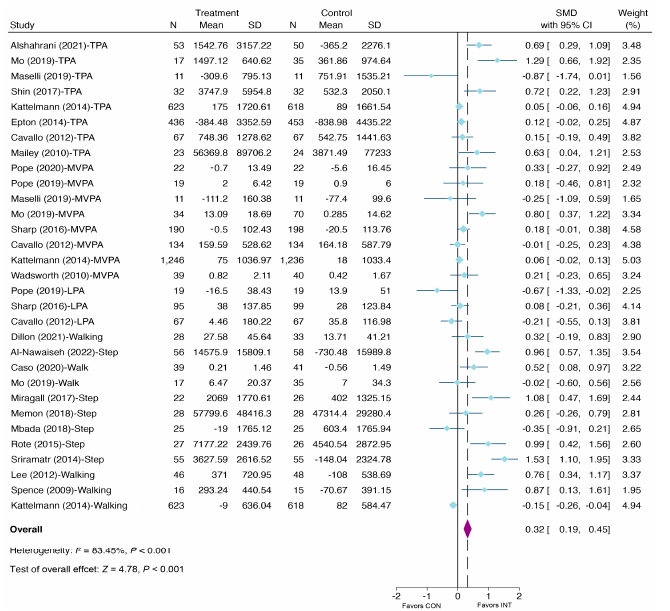
Figure 4. Meta-analysis of effects of e-health interventions on PA at post-intervention versus control [36,37,44–63]. A meta-analysis of the random effect model for five effect sizes reporting SB-related outcomes found that the e-health intervention did not reduce SB significantly at post-in- tervention compared to the control group (MD = − 29.11, 95% CI: − 70.55, 12.32, p = 0.17) (see Figure 6). Considering the small number of studies reporting SB, no test for publica- tion bias was performed.